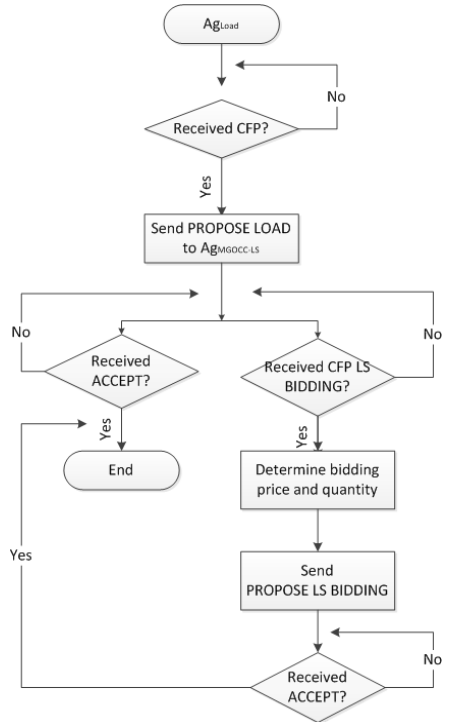
Figure 3. Flow chart for load shedding of Ag